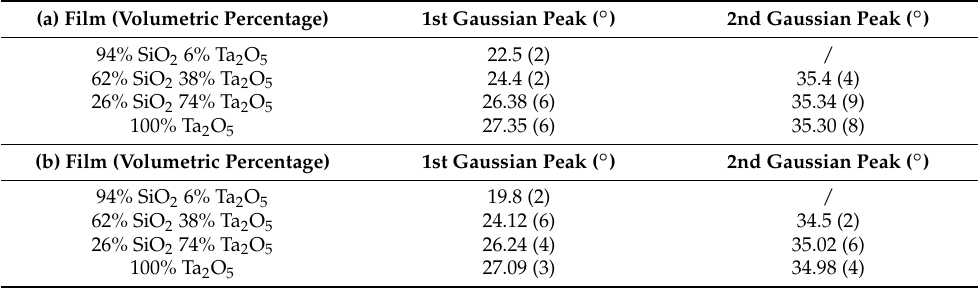
Table 1. Best-fit peak angular positions of GIXRD curves shown in Figure 2 referred to 0.6 ( a ) and 2.0 mm slit widths ( b